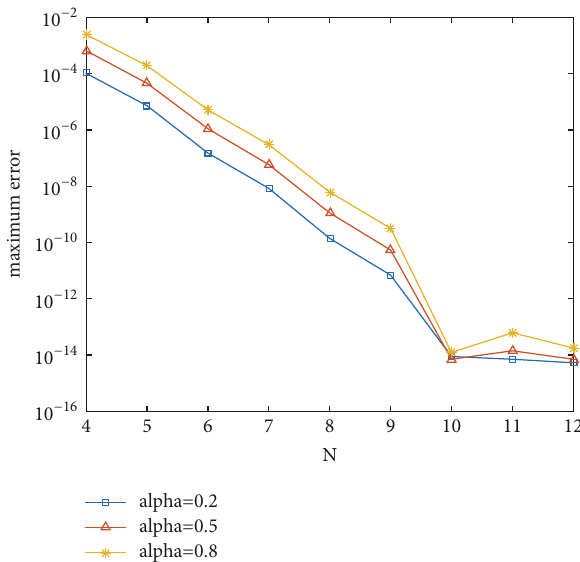
Figure 1: Error of numerical approximation to generalized frac- tional derivative of 𝑦(𝑥) .